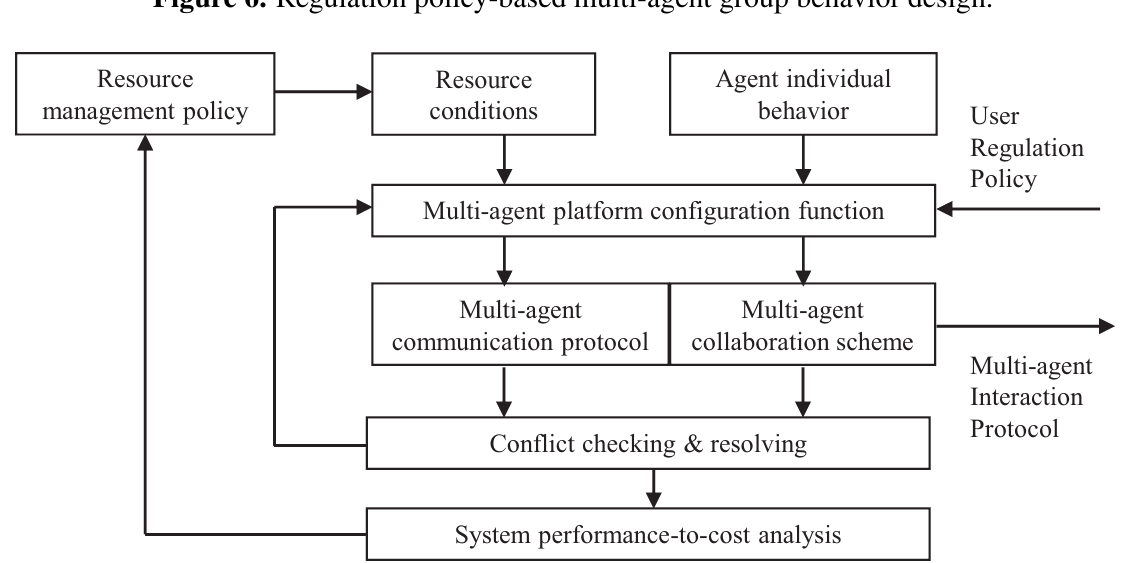
Figure 6. Regulation policy-based multi-agent group behavior design.